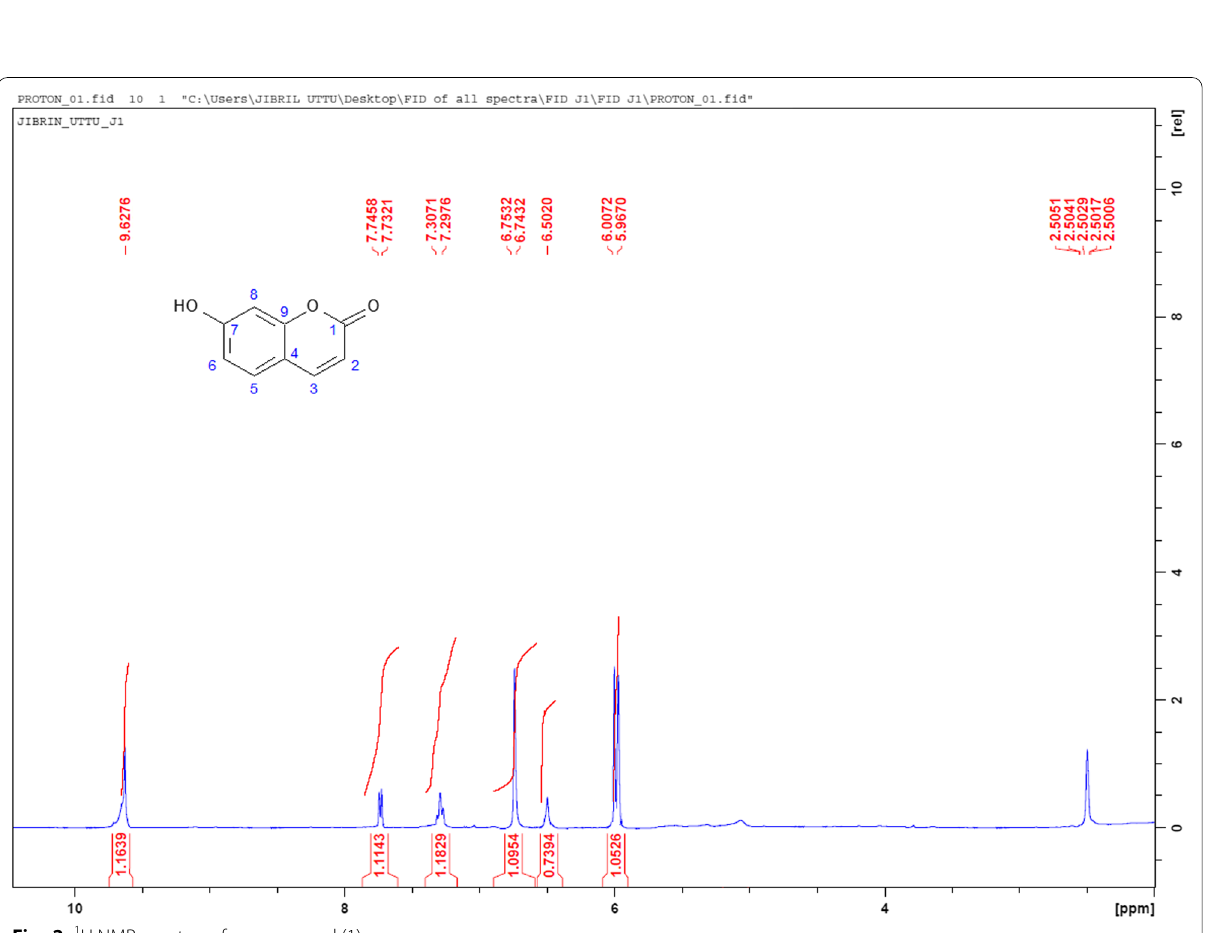
Fig. 2 1 H NMR spectrum for compound